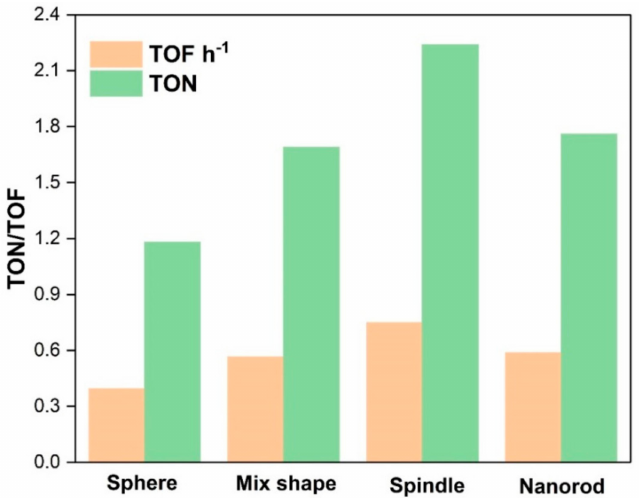
Figure 5. Catalytic activities of CeO 2 catalysts for the synthesis of DMC with respective